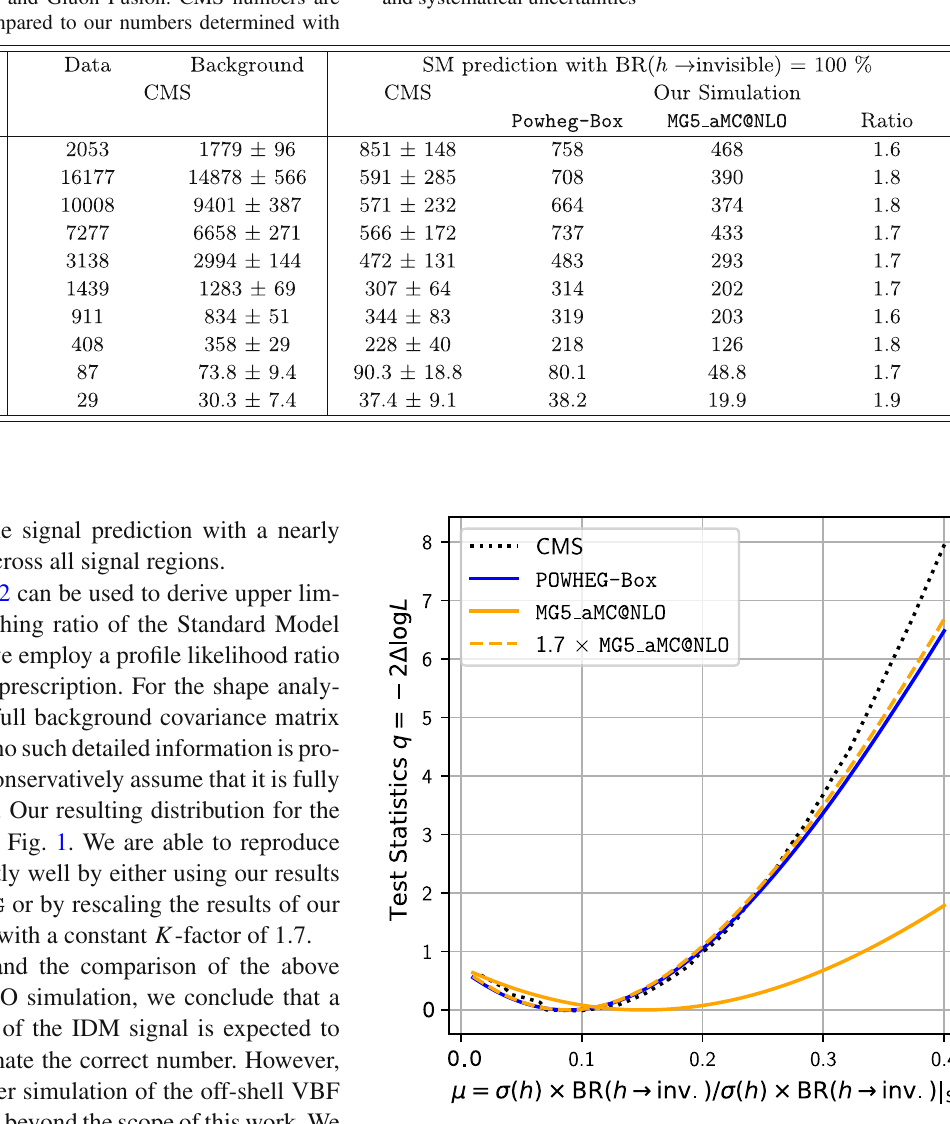
our analysis implementation in CheckMATE , using both the LO-QCD